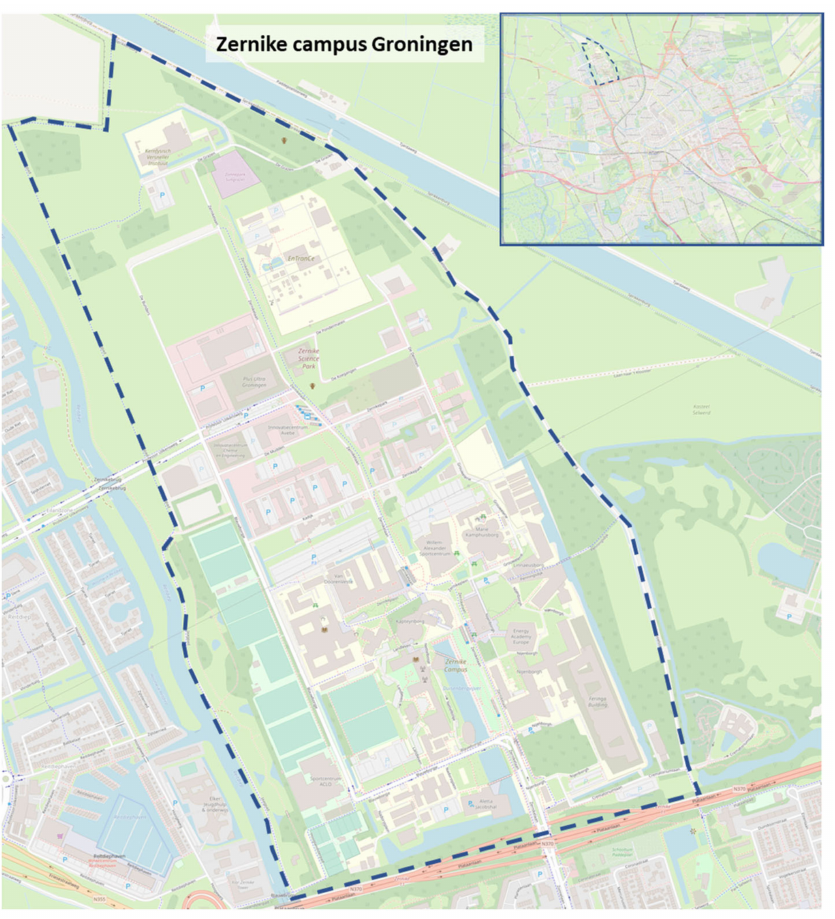
Figure 2. Zernike campus [37]. Map data copyrighted OpenStreetMap contributors and available from https://www.openstreetmap.org, accessed on 13 December 2022.